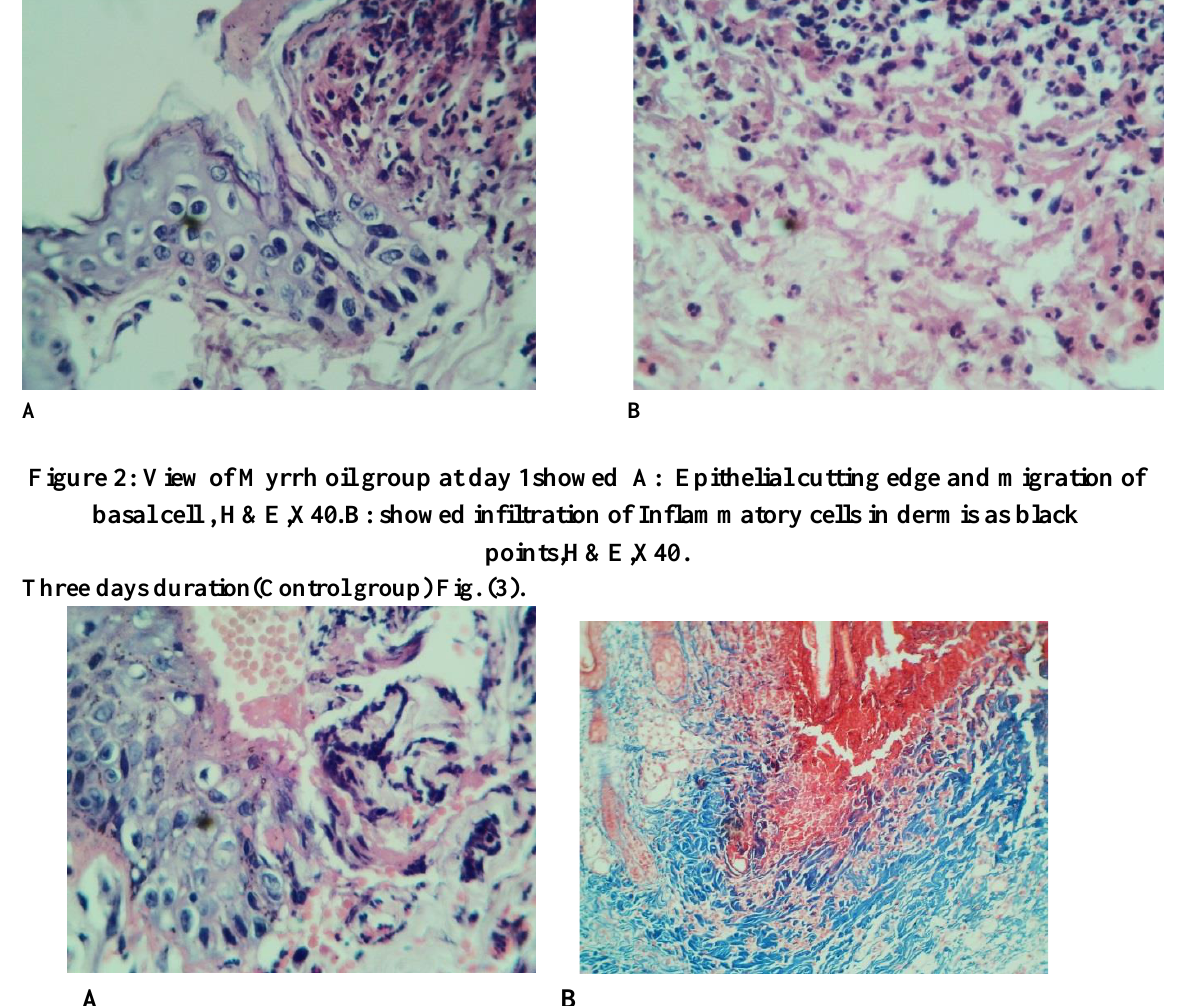
Figure 3: View of control group at day 3 showed showed A: epithelial proliferation, H&E, X40 B: Fine collgen fiber and granulation tissue MTX10. Three days duration Experimental group(M) Fig . 4.